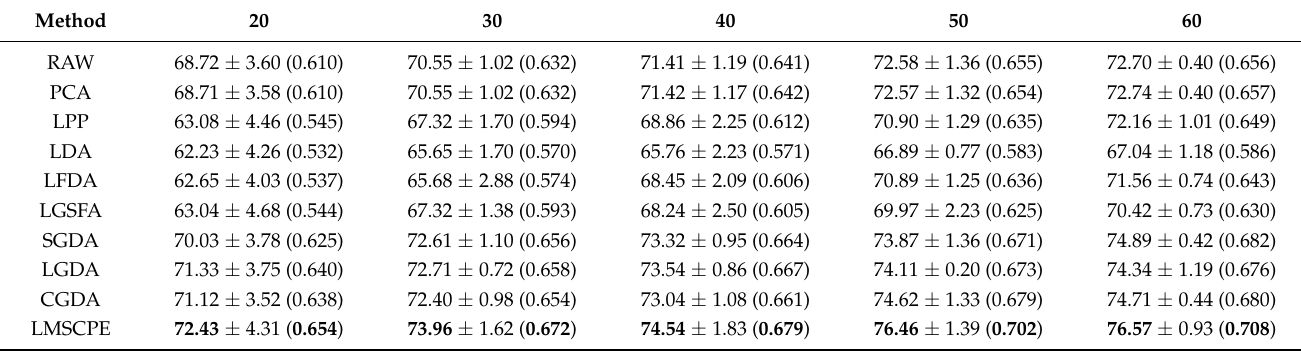
Table 3. Classification results of each method with different training sample sizes on the MUUFL dataset [OA ± STD (%)(KC)]. (OA—overall classification accuracy, STD—standard deviation, KC—kappa coefficient, and the best results of a column are marked in